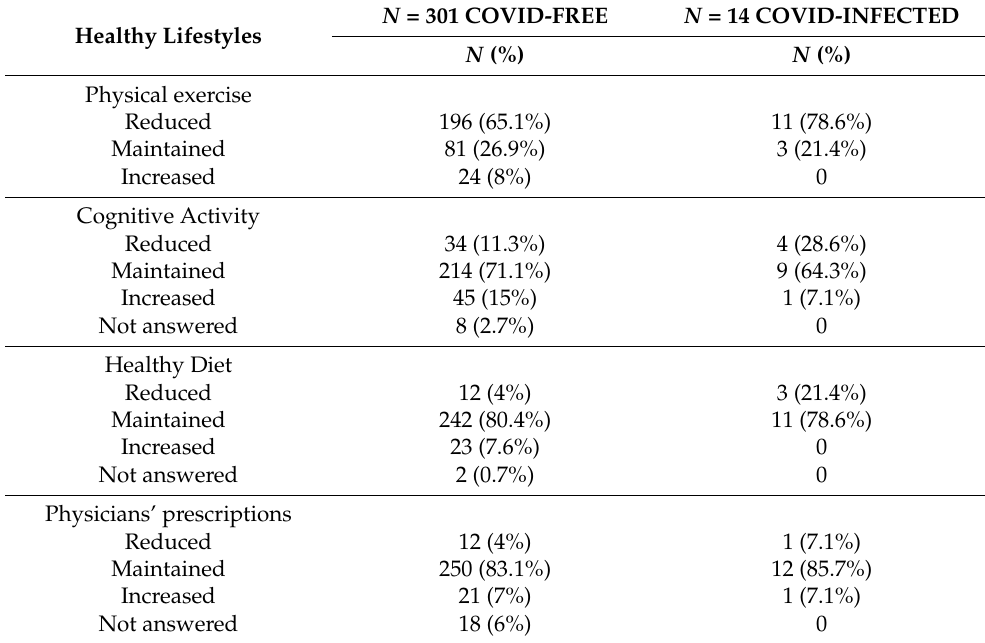
Table 3. Healthy lifestyle changes during the COVID-19